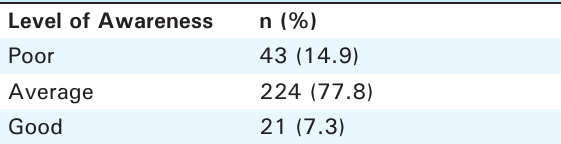
Table 3. Mother’s Level of Awareness on Girl Child